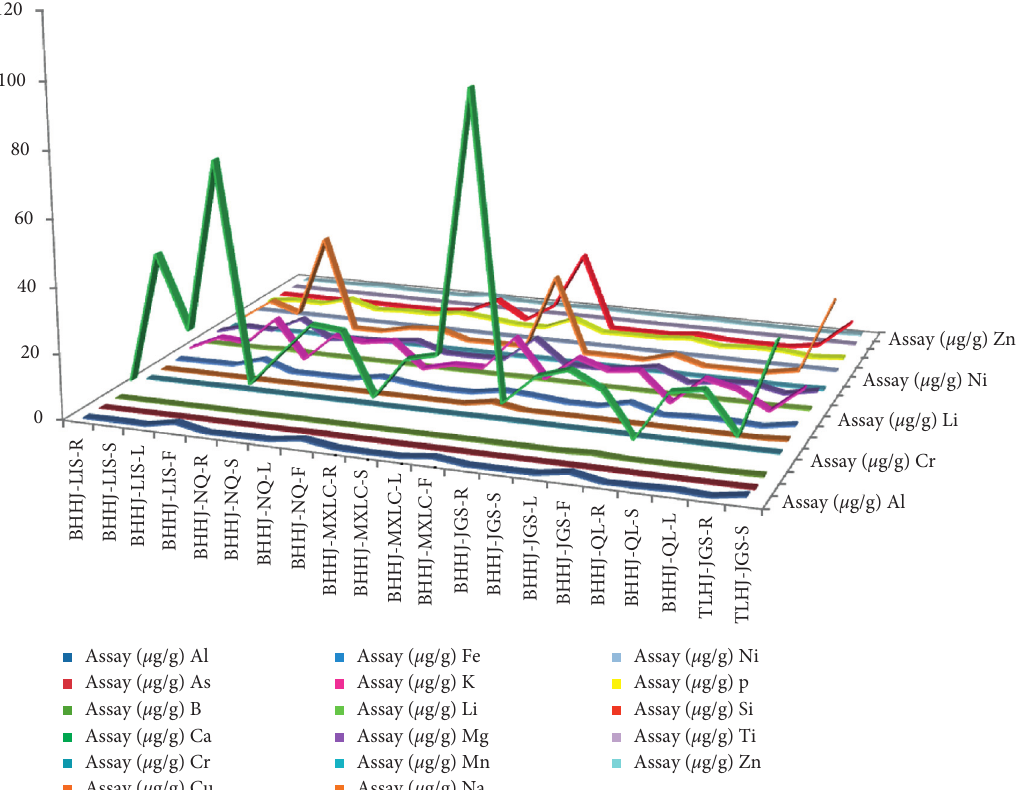
Figure 2: Contents of diverse elements from the different areas and tissues. Note: BHHJ-LJS-R/S/L/F: root, stem, leaf, and flower of Guide County from Hainan Autonomous Prefecture of Corydalis conspersa ; BHHJ-NQ-R/S/L/F: root, stem, leaf, and flower of Nangqian County from Yushu Autonomous Prefecture of Corydalis conspersa ; BHHJ-MXLC-R/S/L/F: root, stem, leaf, and flower of Zeku County from Huangnan Autonomous Prefecture of Corydalis conspersa ; BHHJ-JGS-R/S/L/F: root, stem, leaf, and flower of Henan County from Huangnan Autonomous Prefecture of Corydalis conspersa ; BHHJ-QL-R/S/L: root, stem, and leaf of Qilian County from Haibei Au- tonomous Prefecture of Corydalis conspersa ; TLHJ-JGS-R/S: root and stem of Henan County from Huangnan Autonomous Prefecture of Corydalis linarioides